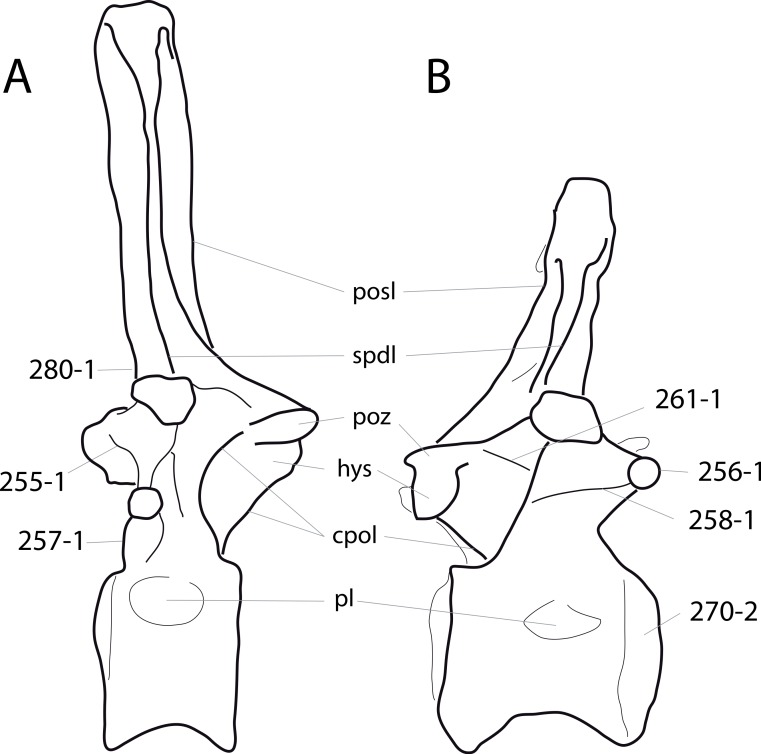
Diplodocid posterior dorsal vertebrae.Posterior dorsal vertebrae of Apatosaurus louisae CM 3018 (A; traced from Gilmore, 1936) and Supersaurus vivianae BYU 9044 (B; traced from Jensen, 1985) in left (A) and right (B) lateral view. Note the prpl (A; C255-1), the anteriorly displaced parapophysis (B; C256-1), the acpl (A; C257-1), the pcpl (B; C258-1), the lateral branch of the cpol (B; C261-1), the pronounced opisthocoely (B; C270-2), and the anteriorly inclined base of the neural spine (A; C280-1). Abb.: cpol, centropostzygapophyseal lamina; hys, hyposphene; pl, pleurocoel; posl, postspinal lamina; poz, postzygapophysis; spdl, spinodiapophyseal lamina. Scaled to same posterior cotyle height.